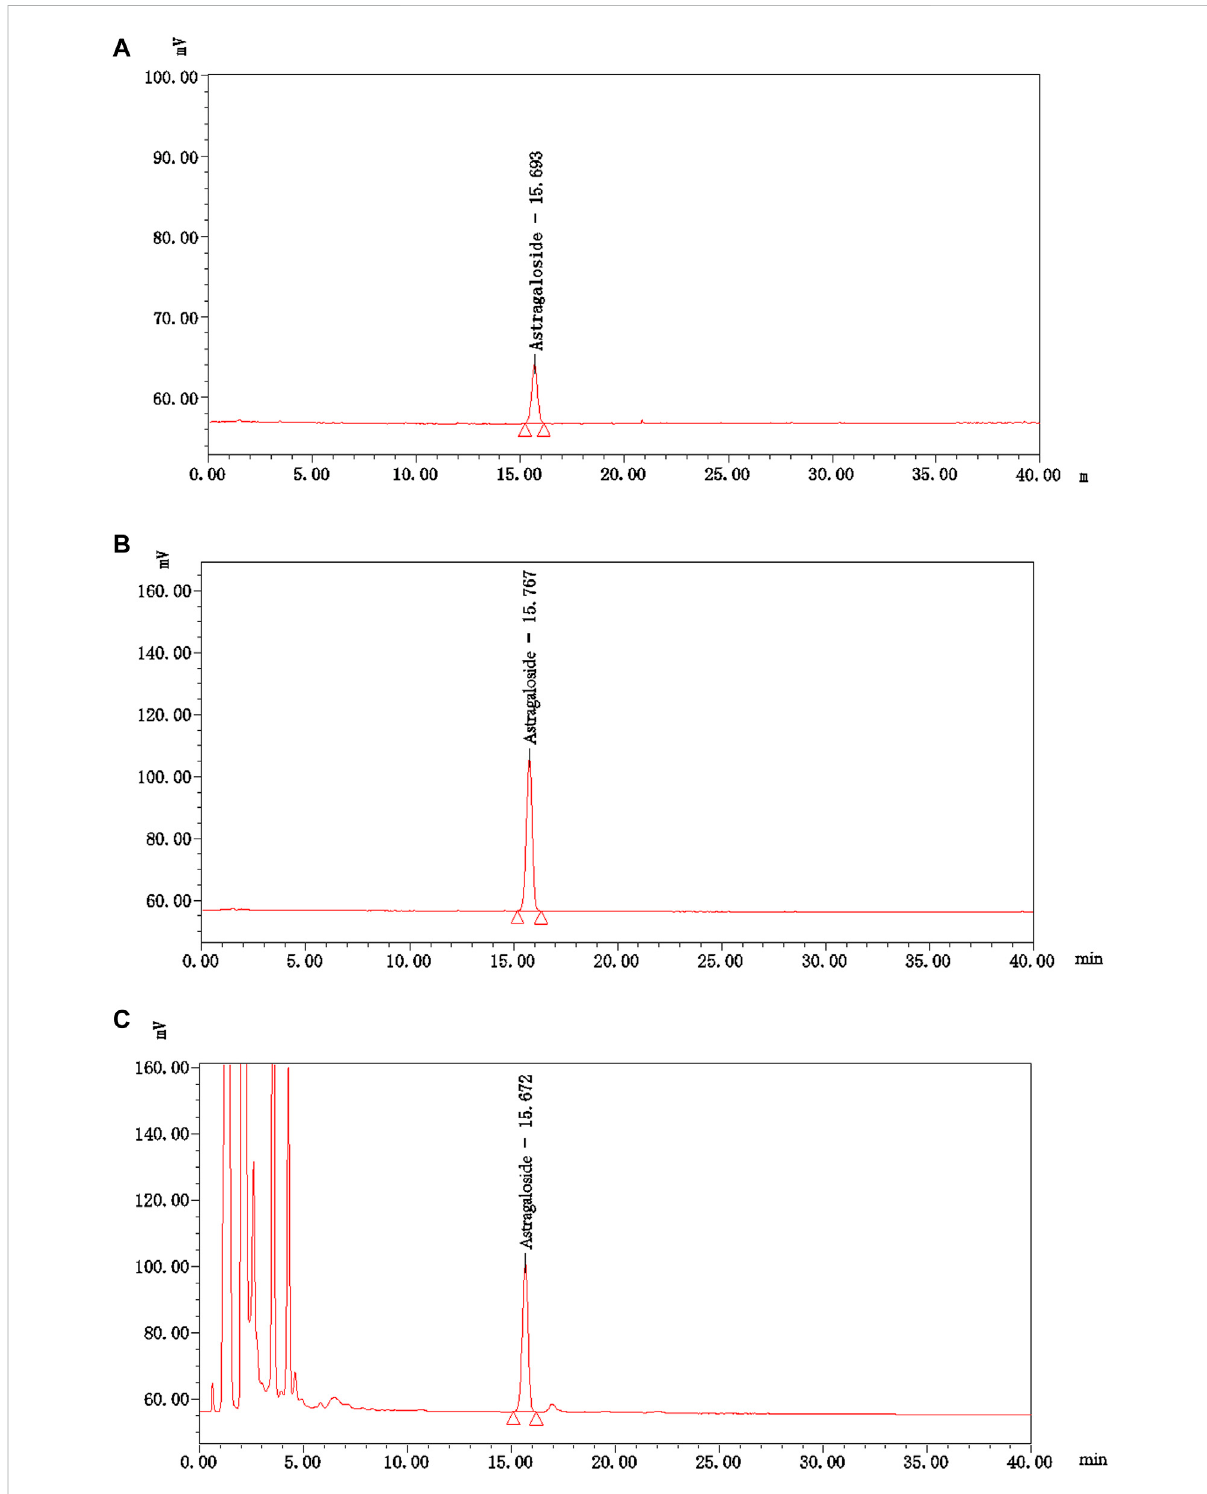
FIGURE 4 TheHPLCchromatogramsofastragaloside AandNTFcapsules. (A) Thecontrolsample(astragalosideA)solution-10 μ L; (B) Thecontrolsample (astragaloside A) solution-30 μ L; (C) The test sample (NTF capsules) solution-20 μ